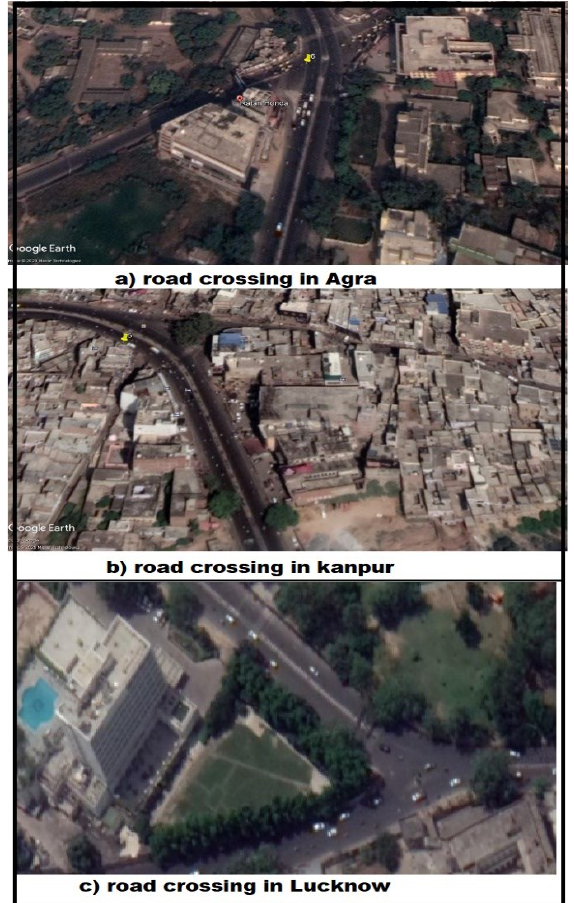
Figure 2. Google map road crossing image